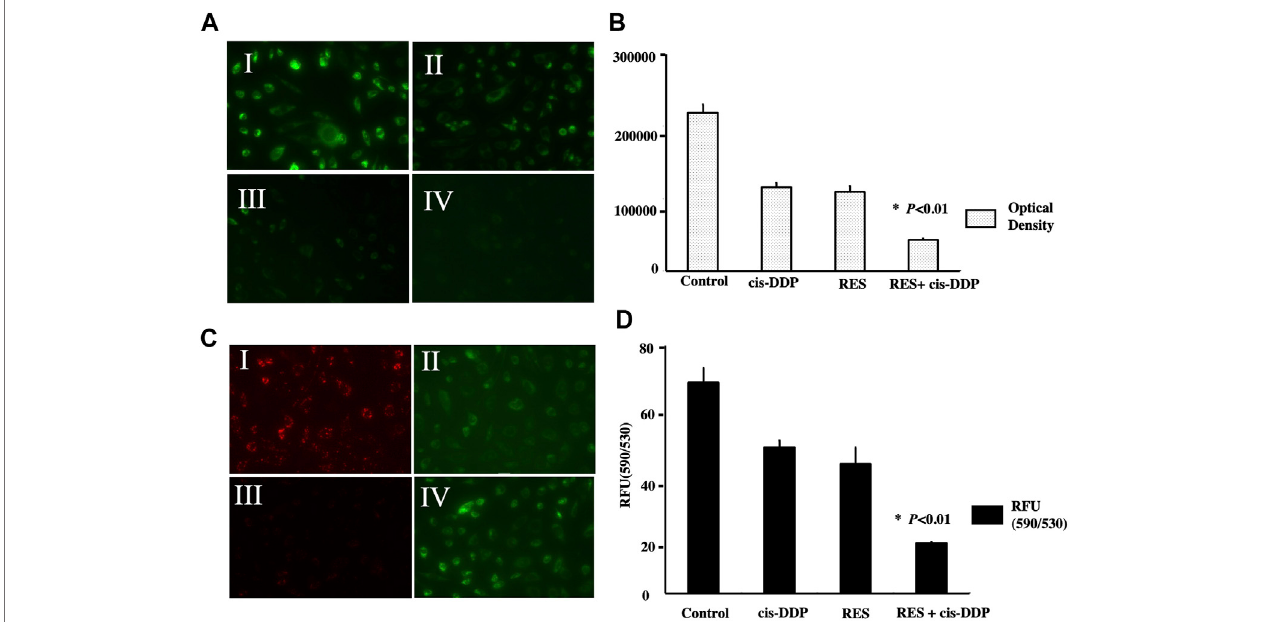
FIGURE 2 | Res + cis-DPP decreased the ROS content and enhanced mitochondrial transmembrane potential ( ΔΨ m) in SiHa cells. (A) Intracellular ROS were detected by H2DCF-DA fl uorescent probe (green) with a fl uorescence microscope, and the laser output wavelength range was 460 – 490 nm with 100 mW/cm 2 power density. Images I, II, III, and IV represent vehicle control, cis-DDP, RES, and RES + cis-DDP, respectively. (B) Intracellular DCF fl uorescence (an indicator of ROS formation) was recorded as the optical density, and it showed that RES + cis-DDP had the lowest ROS expression among all groups (* p < 0.01). (C) Images of the mitochondrial membrane potential assay (JC-1 method). Images I, II, III, and IV represent vehicle control, cis-DDP, RES, and RES + cis-DDP, respectively. In cells with high ΔΨ m; the JC-1 wasaccumulated and appeared red color under a fl uorescence microscope (image c-I). In cells with low ΔΨ m, the less concentrated JC-1 showed green color (images c II and IV). (D) JC-1 fl uorescence was recorded and converted into relative fl uorescence units (RFU), and it showed that RES and/or cis-DDP signi fi cantly reduced ΔΨ m compared with the control group; the RES + cis-DDP group had the lowest ΔΨ m among all groups ( p <